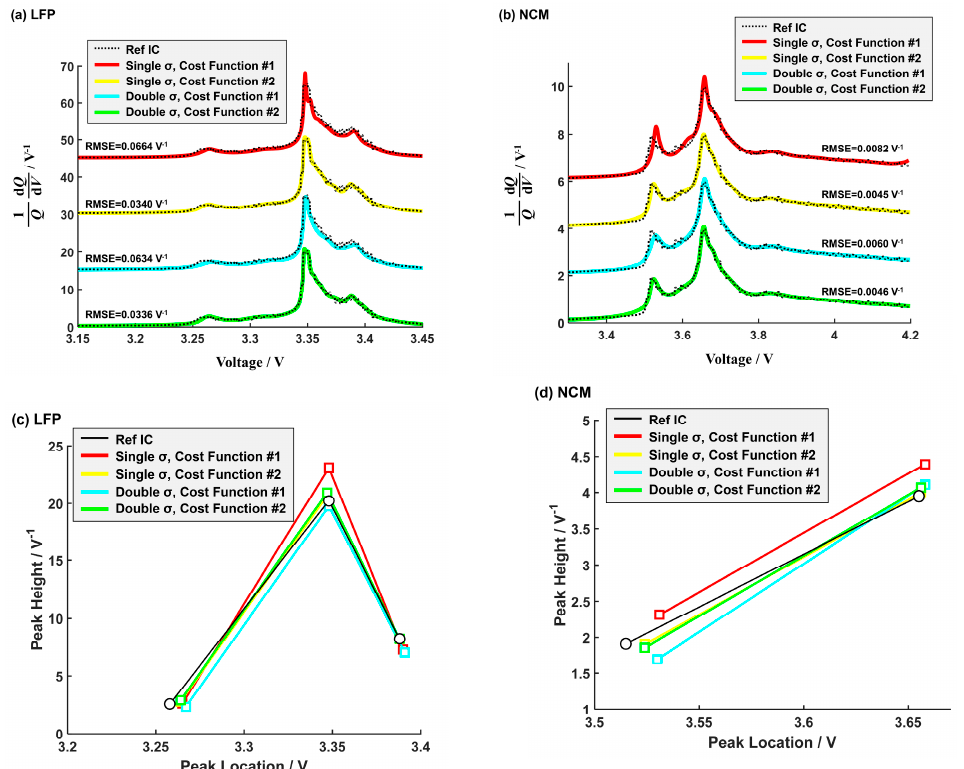
Figure 10. Comparisons of the fitting results of IC curves for the SVR algorithms with different settings. Comparison of the fitted IC curves for ( a ) Cell A with LFP cathode; ( b ) Cell B with NCM cathode. Comparison of the locations and heights of the peaks in the IC curves for ( c ) Cell A with LFP cathode; ( d ) Cell B with NCM